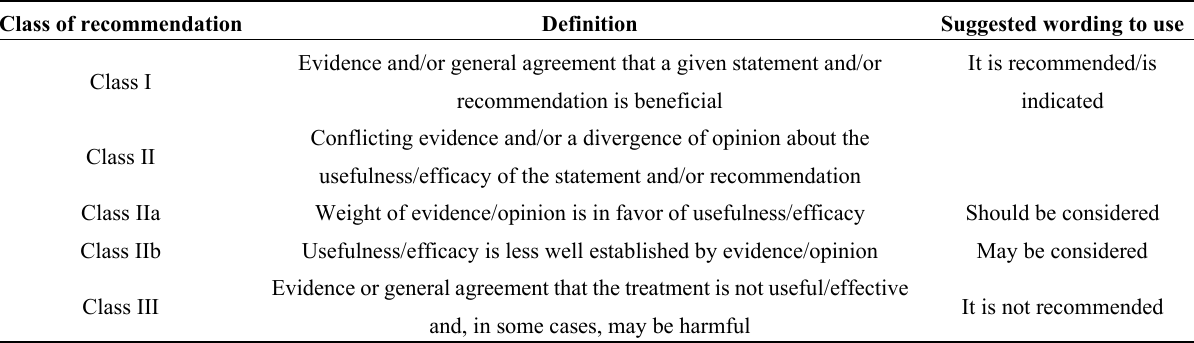
Table 2. Strength of statement and/or